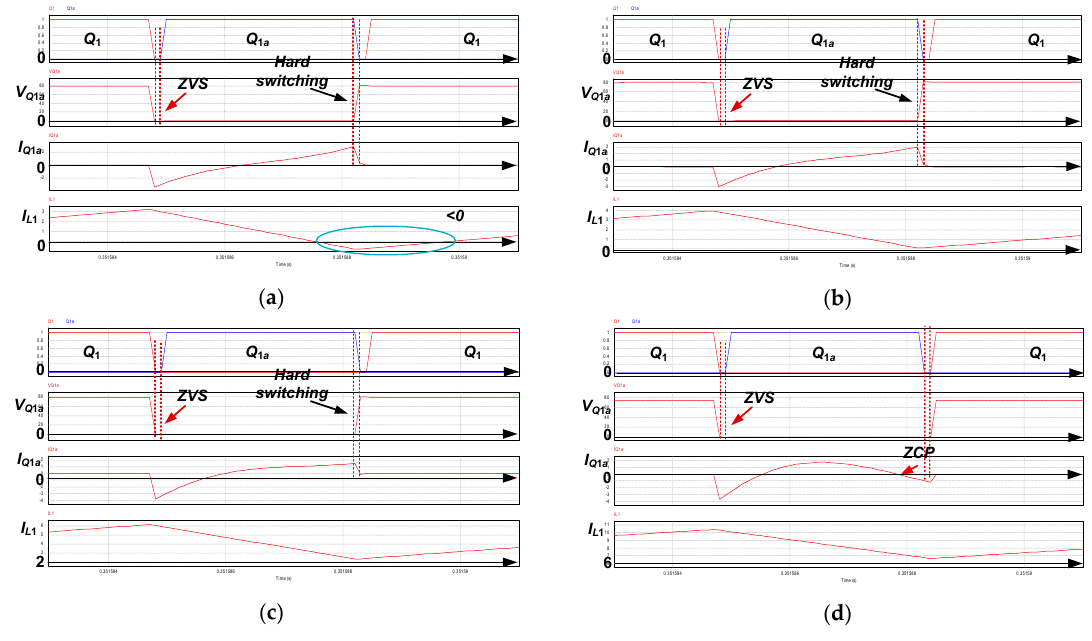
Figure 10. Typical waveforms of Q 1 a and I L 1 with a same L but different d Qs : ( a ) R = 52 Ω , d Qs = 0, η = 94.5%; ( b ) R = 52 Ω , d Qs = 0.5, η = 94.1%; ( c ) R = 52 Ω , d Qs = 1, η = 90.8%; ( d ) R = 20 Ω , d Qs = 1.